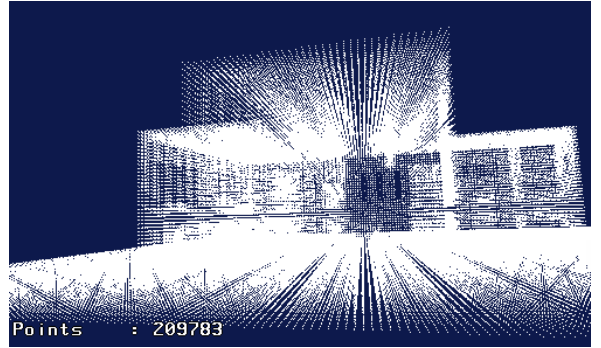
Fig. 14. Voxel cloud of the model in Fig.12. The voxels are represented as